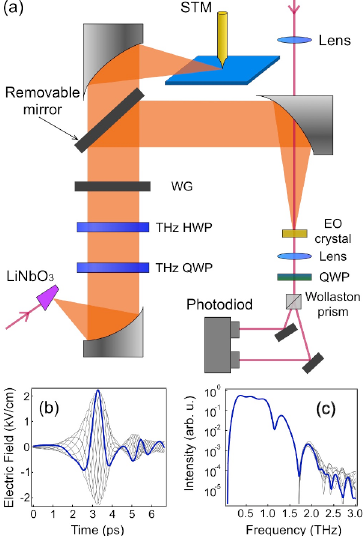
Fig. 1 (a) Schematic of the experimental setup. (b) Far-field single-cycle THz waveforms with different CEPs measured via electro-optic sampling. The lines show the CEP-controlled waveforms for every (2/9) π shift. (c) Fourier-transformed spectra of